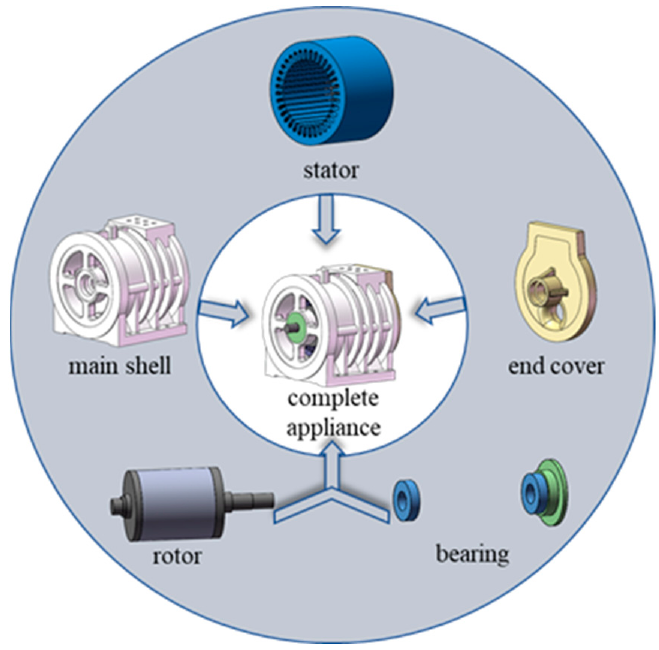
Figure 11. Simulation model.